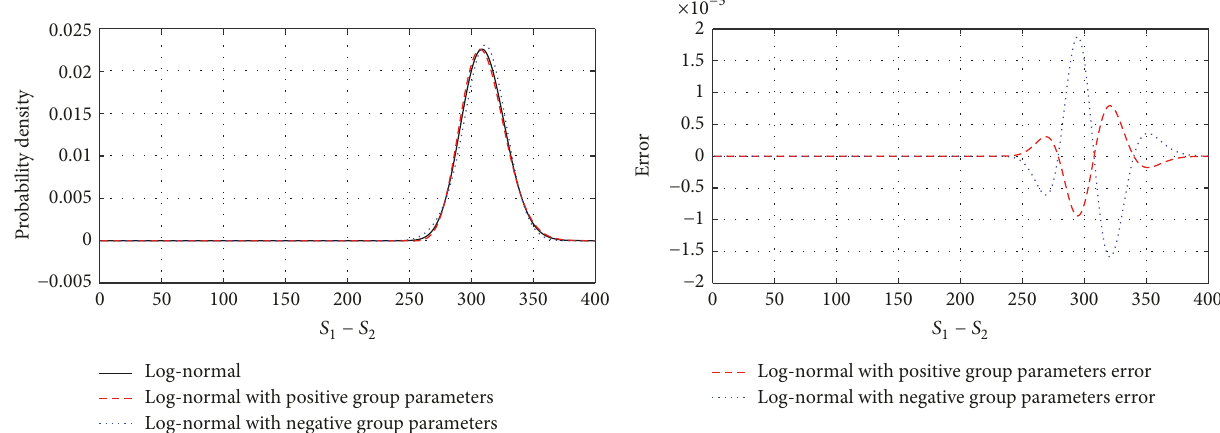
Figure 2: Difference of probability density function: 𝑥 10 = 110 , 𝑥 20 = 100 , 𝜎 1 = 0.25 , 𝜎 2 = 0.15 , 𝜌 = −0.5 , and 𝑡 − 𝑡 0 = 1